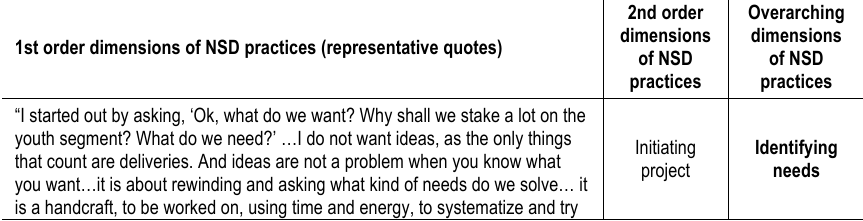
Table 3. Empirical data supporting interpretations of NSD